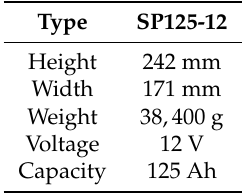
Figure 5. Electric vehicle and batteries. Table 3. Main battery